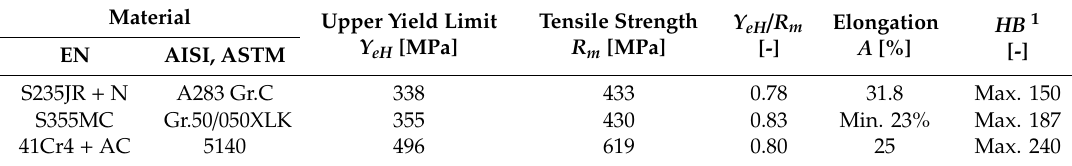
Table 2. Mechanical properties of investigated steels